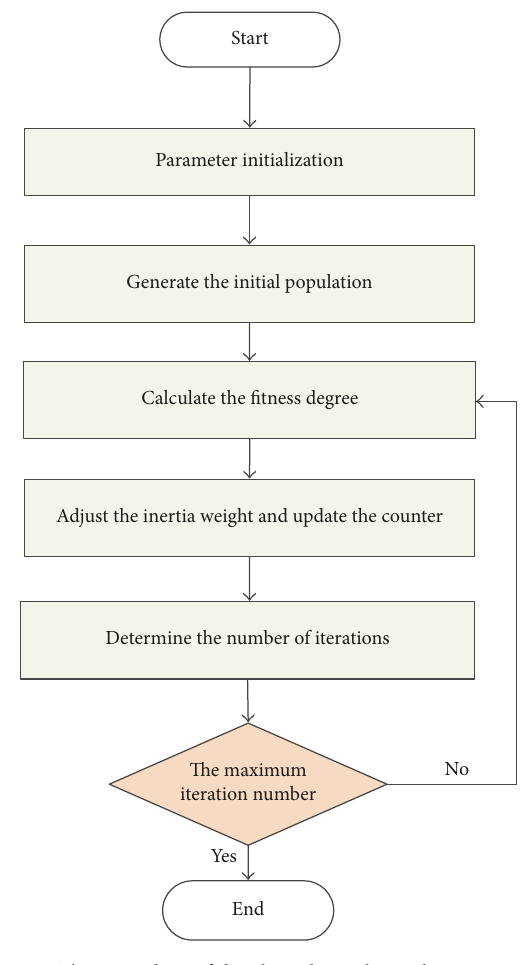
Figure 1: The procedure of the algorithm solving the proposed test selection optimization model. Table 1: The testability indicators for the superheterodyne